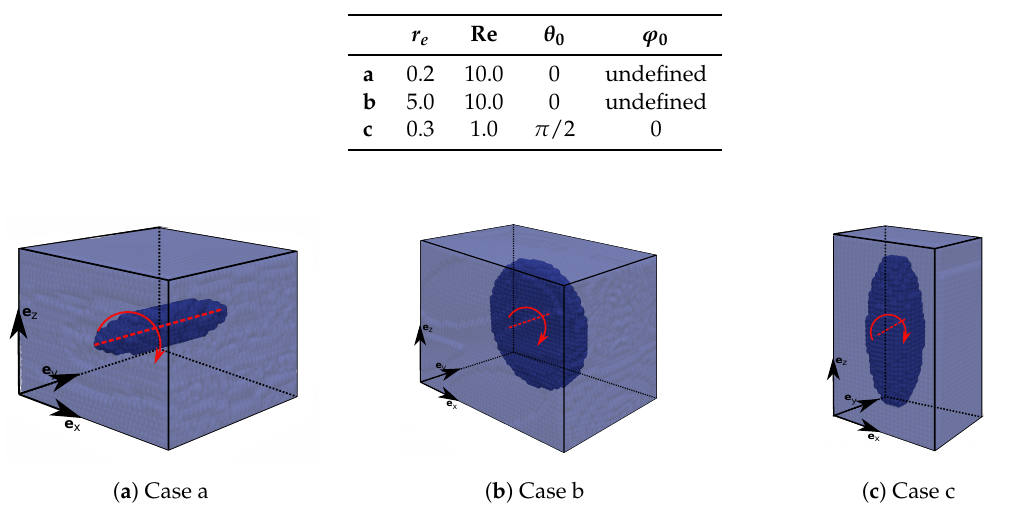
Figure 6. Initial configurations and rotation axis and direction of the three considered cases ( a – c ).